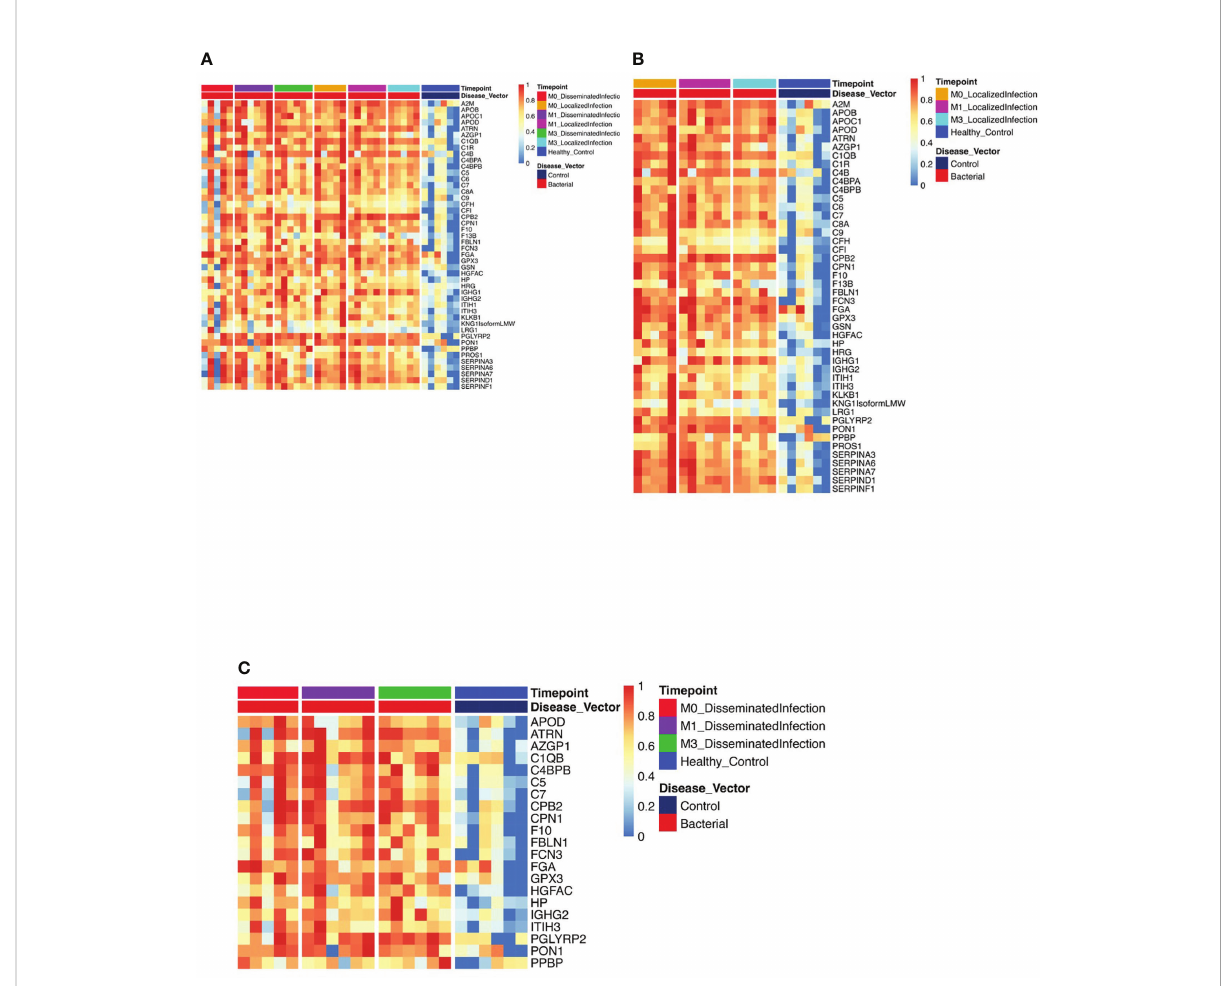
FIGURE 1 Protein Expression across Lyme Disease Timepoints. Serum samples from LD patients were assessed by the dHSP platform. The limma package was used to identify differentially expressed proteins in a combined dataset of healthy controls and patients with statistically signi fi cant proteins de fi ned with FDR ¾= 0.05. (A) Normalized heatmap displays the progression of abundant proteins (n=46) in both disseminated and localized infections at month 0, 1, and 3 (M0, M1, M3) compared to healthy controls. (B) Normalized heatmap displays the progression of abundant proteins (n = 66) in localized infections at month 0, 1, and 3 (M0, M1, M3). (C) Normalized heatmap displays the progression of abundant proteins (n = 22) in disseminated infections at month 0, 1, and 3 (M0, M1,